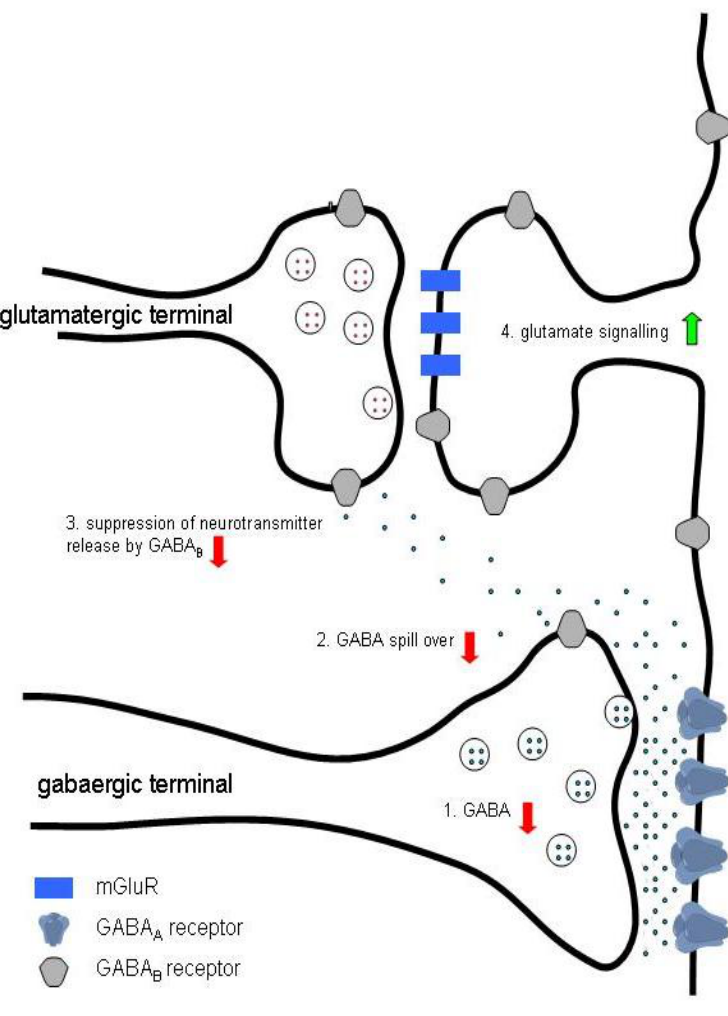
FIGURE 1 . Hypothetical role of the GABA B receptor in fragile X syndrome. (1) GABA synthesis is reduced in the fragile X syndrome. (2) As a consequence, there might be a reduced amount of GABA spill over from the inhibitory synapses. (3) Reduced GABA B receptor stimulation results in a diminished neurotransmitter suppression by presynaptic GABA B receptors on glutamatergic neurons and may explain (part of) the excessive glutamate signaling observed in the fragile X syndrome